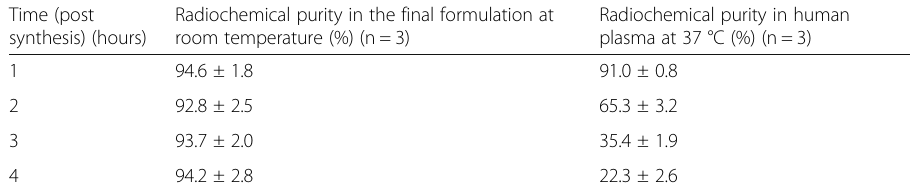
Table 2 Stability of the radiopharmaceutical in human plasma and in the final formulation up to 4 hs Time (post synthesis)